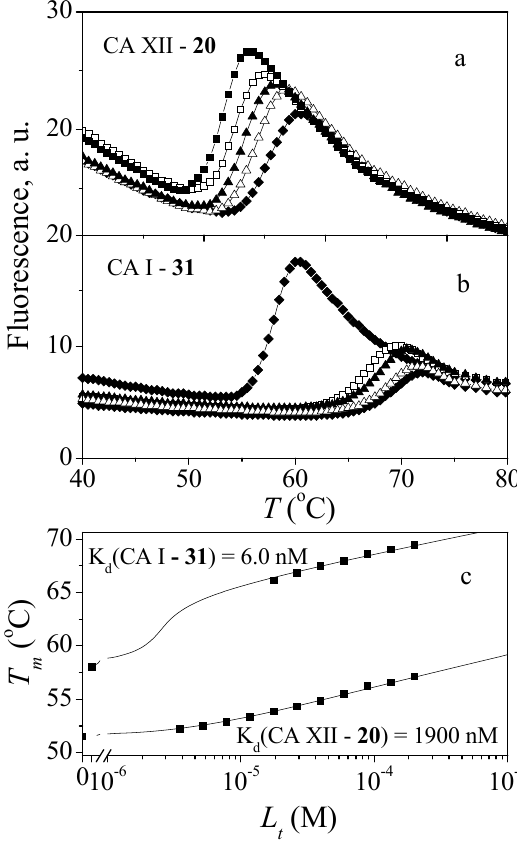
Figure 1. The fluorescent thermal shift assay (FTSA) data for compound 20 binding to CA XII ( a ) and 31 binding to CA I ( b ). Panels on the top (a,b) show the protein melting curves at several added compound concentrations. Panel on the bottom ( c ) shows the dependence of the protein melting temperatures T m on ligand concentrations. Datapoints are from the experimental values from the upper panels and the curves in panel c are simulated according to the model